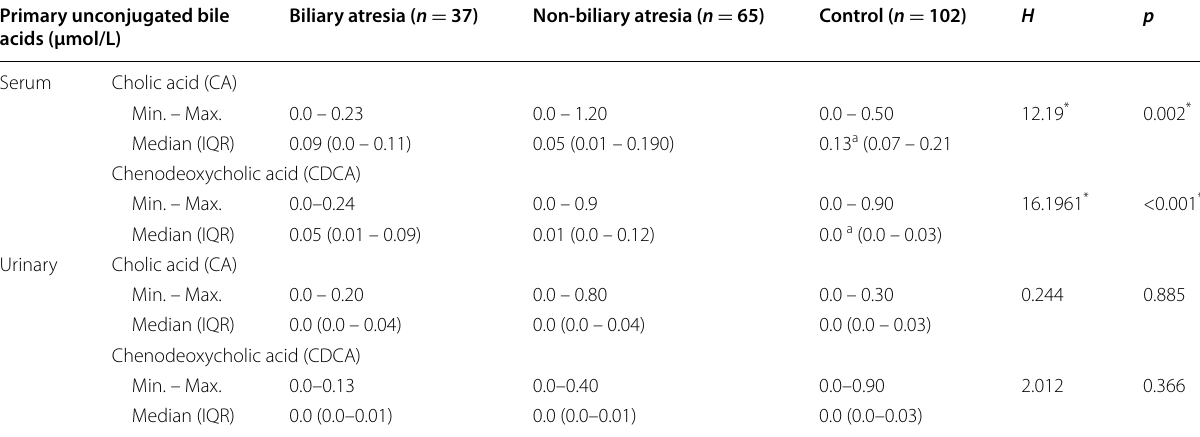
Table 4 Comparison between the two cholestatic groups (BA & non‑BA) and control regarding primary unconjugated bile acids in serum and urine